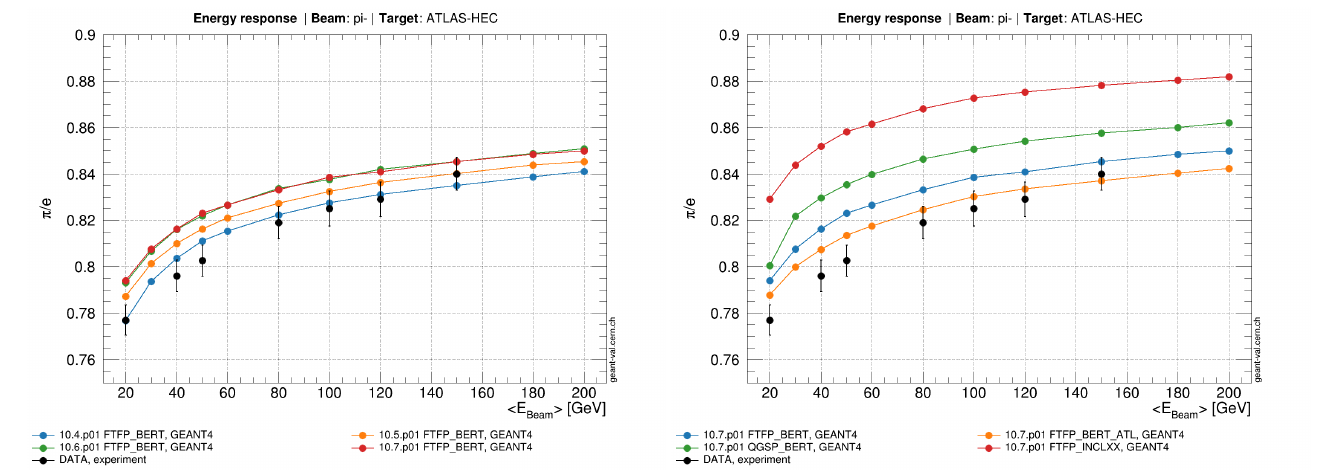
Figure 2. Left : π / e comparison of the Geant4 FTFP_BERT PL prediction for recent releases (2017–2020) with the experimental data. Right : Comparison of several PL predictions from Geant4 10.7.p01 for the same variable.